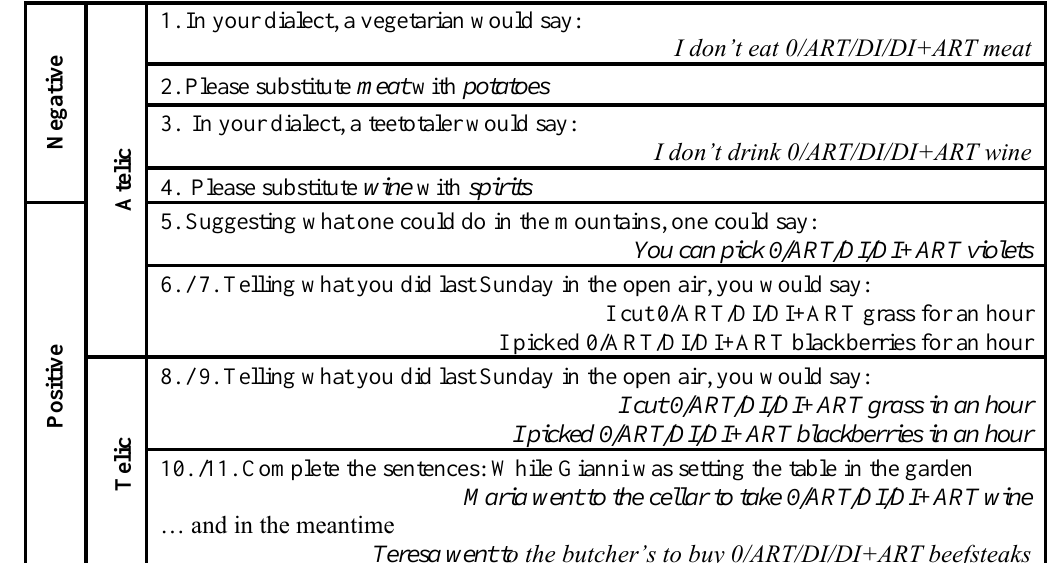
Source: adapted from Giusti